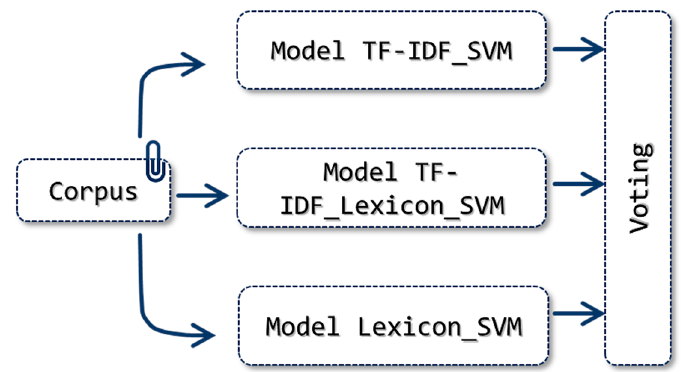
Figure 11. TF-IDF_Lexicon_E_SVM Model.